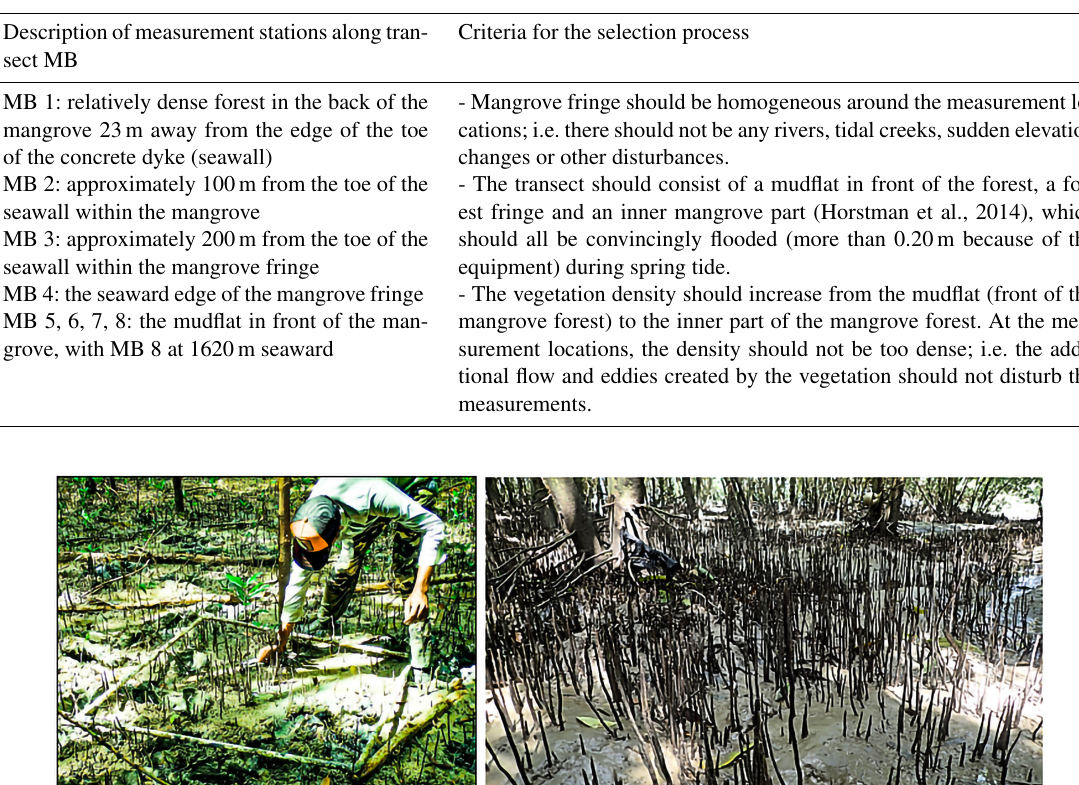
ment’s power signal ( V ) to turbidity (NTU,